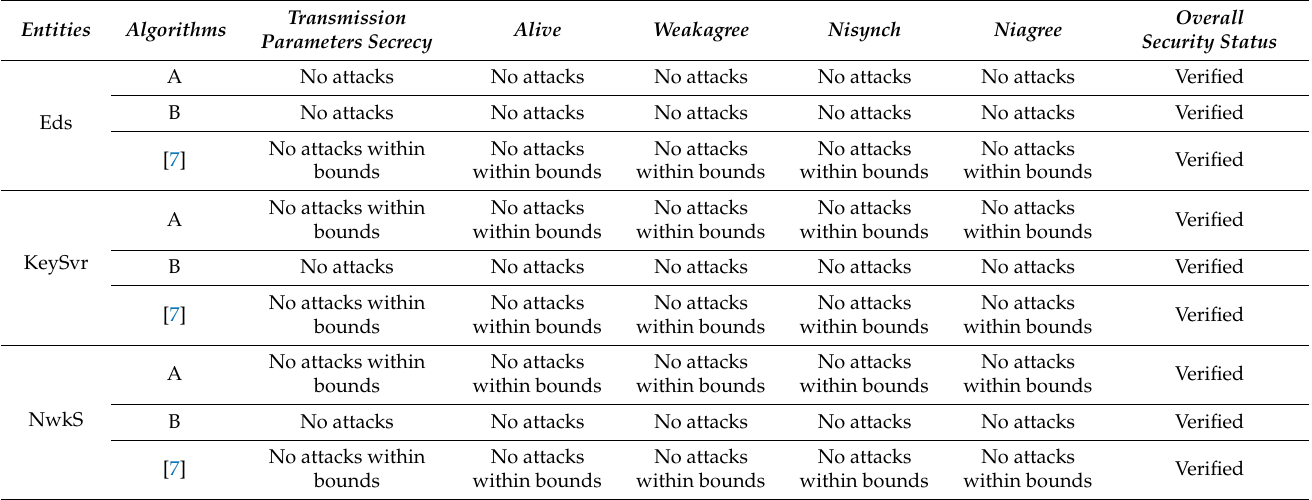
Table 5. Comparison of security claims with similar